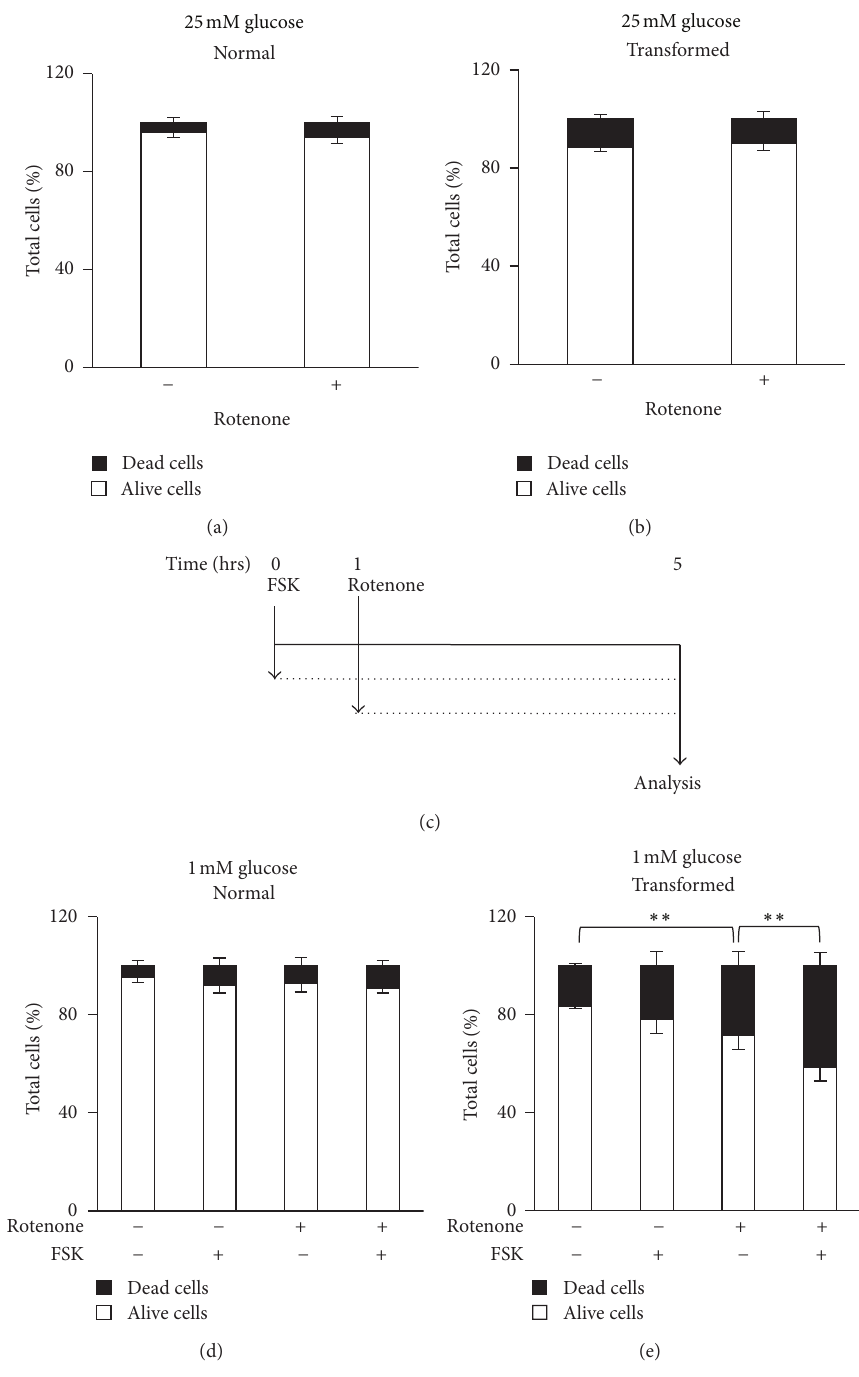
Figure 2: Low doses of rotenone do not affect Normal cells survival as compared to Transformed cells. Viable cell count using Trypan Blue was performed after treatment with rotenone at 72 hours of culture in different growth conditions. (a)-(b) NIH3T3 (a) Normal and (b) Transformed cells were cultured in 25mM glucose and counted after 4-hour treatment with 3nM rotenone. (c)–(e) Cells were cultured in 1mM glucose and treated with 3 nM rotenone, 10 𝜇 M FSK, or both molecules. For the combined treatment, cells were pretreated for 1 hour with FSK and then rotenone was also added for 4 hours as represented in (c). After treatment (d) Normal and (e) Transformed cells were counted. All data represent the average of at least three independent experiments ( ± s.d.); ∗∗ 𝑃 < 0.01 (Student’s 𝑡